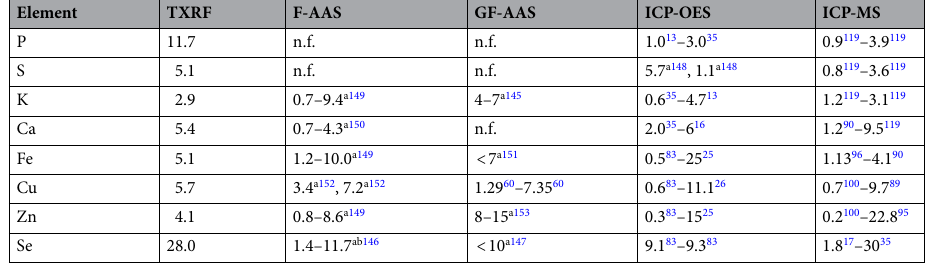
Table 8. Values of repeatability [%] obtained using TXRF for the reference material IAEA-A-13 with the lowest and highest values of these parameters met in examined literature. a Value from the paper that does not concern the analysis biomedical samples; b Determined using HG-AAS; n.f. Value not found in discussed papers or not expressed in consistent